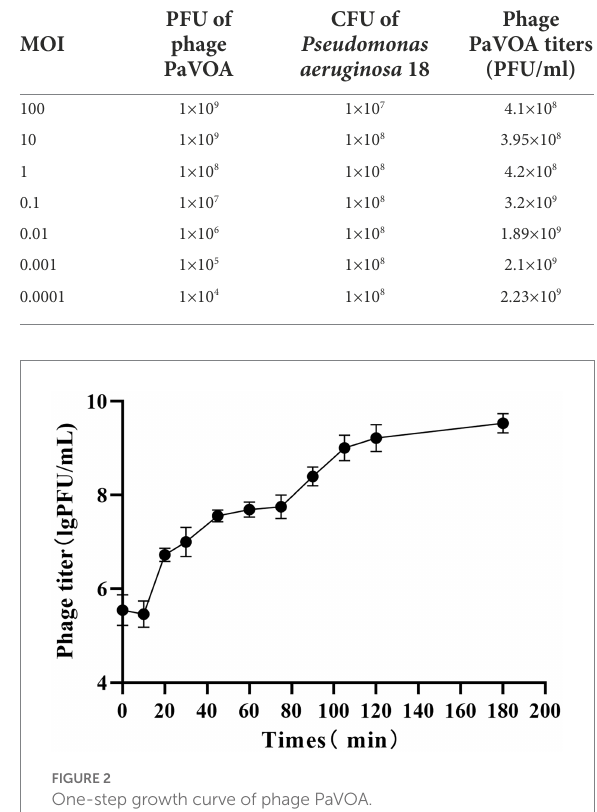
FIGURE 2 One-step growth curve of phage